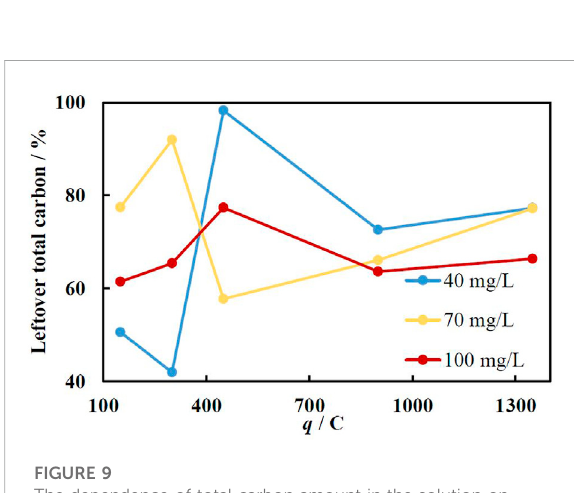
FIGURE 9 The dependence of total carbon amount in the solution